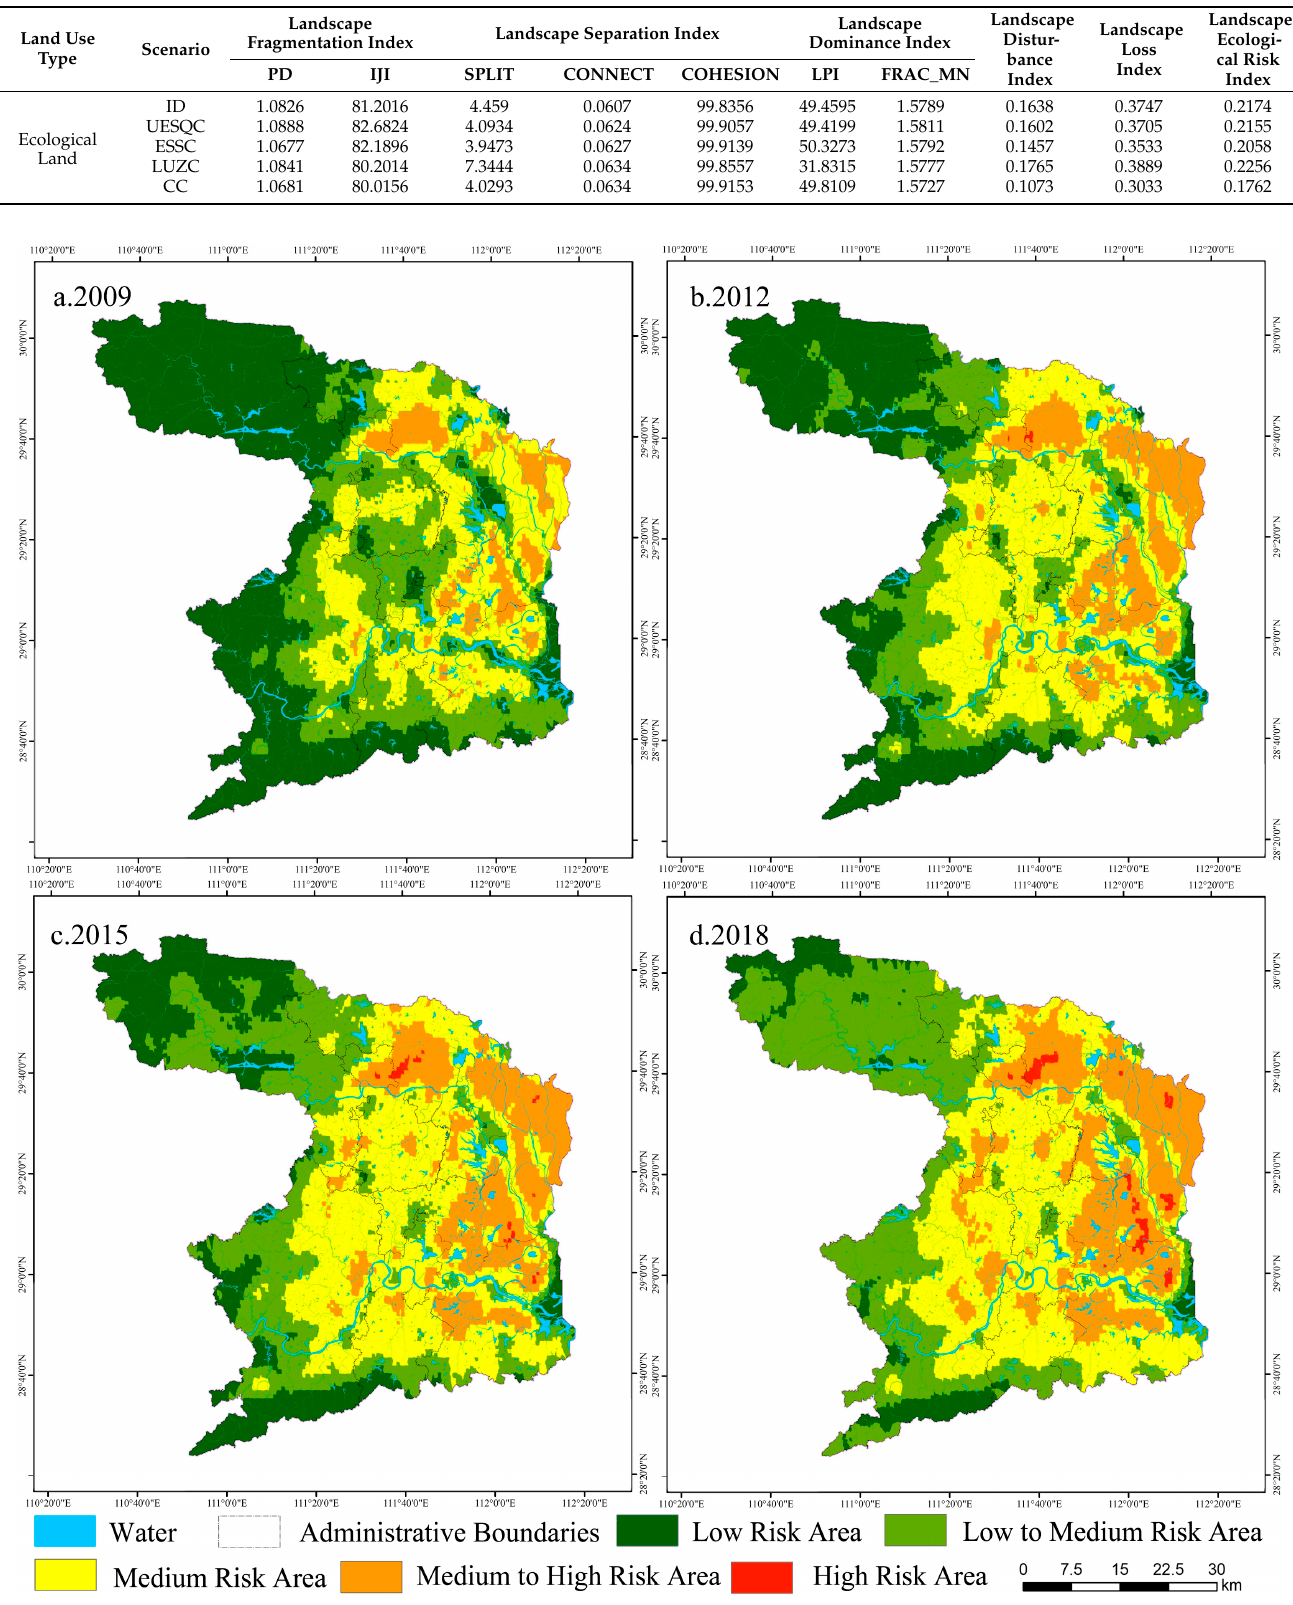
Figure 7. Distribution Map of Landscape Ecological Risk in Changde from 2009 to 2018.